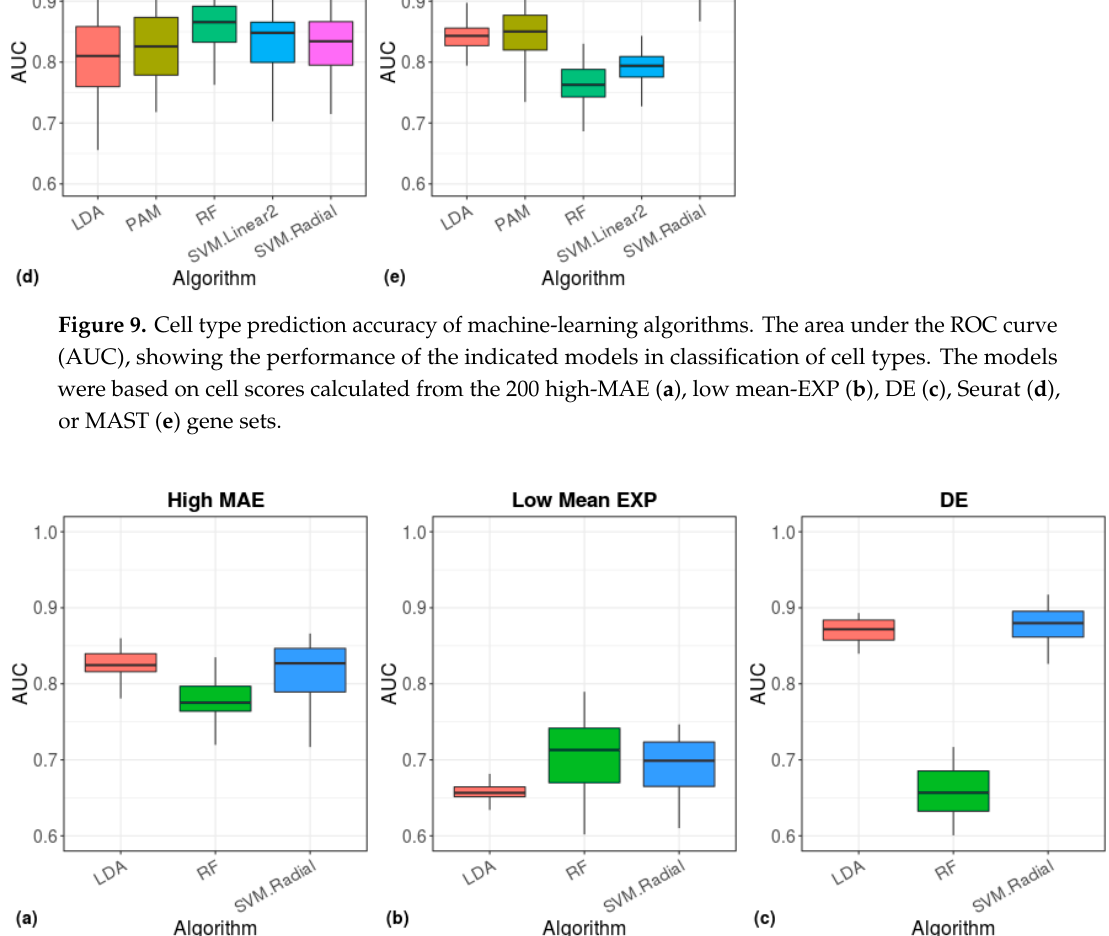
Figure 9. Cell type prediction accuracy of machine-learning algorithms. The area under the ROC curve (AUC), showing the performance of the indicated models in classification of cell types. The models were based on cell scores calculated from the 200 high-MAE ( a ), low mean-EXP ( b ), DE ( c ), Seurat ( d ), or MAST ( e ) gene sets.